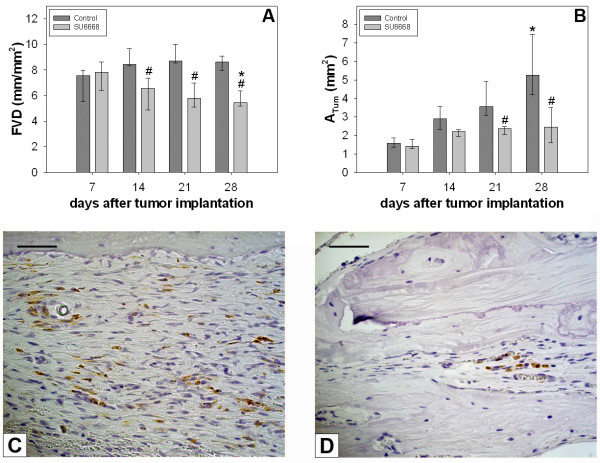
A: Functional vessel density, time course. Y-axis: functional vessel density (FVD in mm/mm2), x-axis: time in days after tumor implantation. SU6668 induced a regression of functional vessel density (FVD), while FVD in Controls increased between day 7 and 14 after tumor implantation, remaining constant thereafter. B: Tumor surface, time course. Y-axis: tumor surface (ATUM in mm2), x-axis: time in days after tumor implantation. In Controls, tumor surface continuously increased over the period of investigation. In contrast to this, SU6668 induced a growth arrest of chondrosarcomas beginning on day 14 after tumor implantation. A and B: Treatment started on day 7 after tumor implantation. Results are given as median with 25% quartiles and 75 % quartiles. Mann-Whitney rank sum test, #p < 0.05 versus Control, *p < 0.05 versus day 7 after tumor implantation. C and D: Immunohistochemistry for CD31 (PECAM-1) on day 28 after tumor implantation confirmed the results of the in vivo quantification of the functional vessel density with intravital microscopy. Untreated Controls showed uniformly distributed CD31 positive cells (brown) within the implanted tumors (C). In SU6668 treated tumors, CD31 positive cells were rare and only detectable in peripheral areas of the tumor residues (D). Scale bars represent 50 μm.